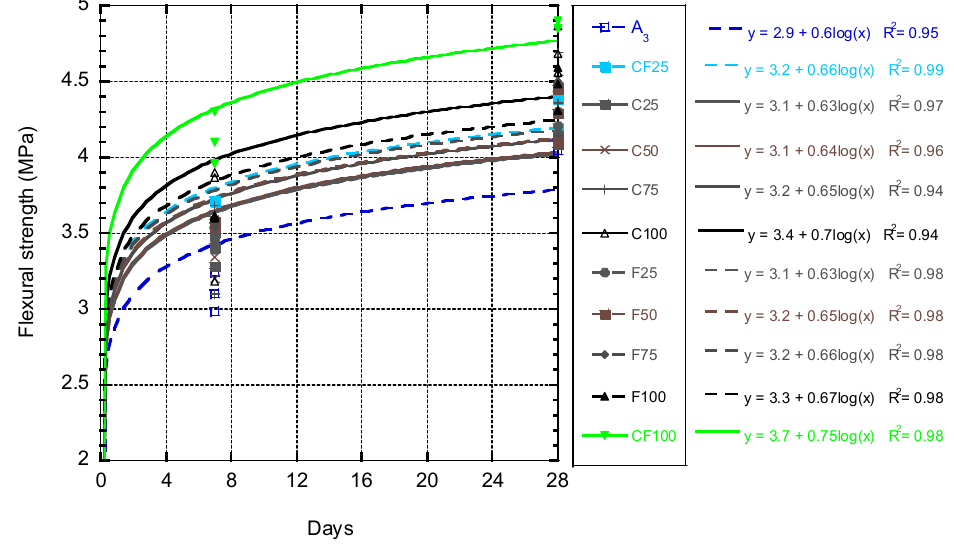
Figure 12. Flexural strength of concrete containing different percentages of EAFS